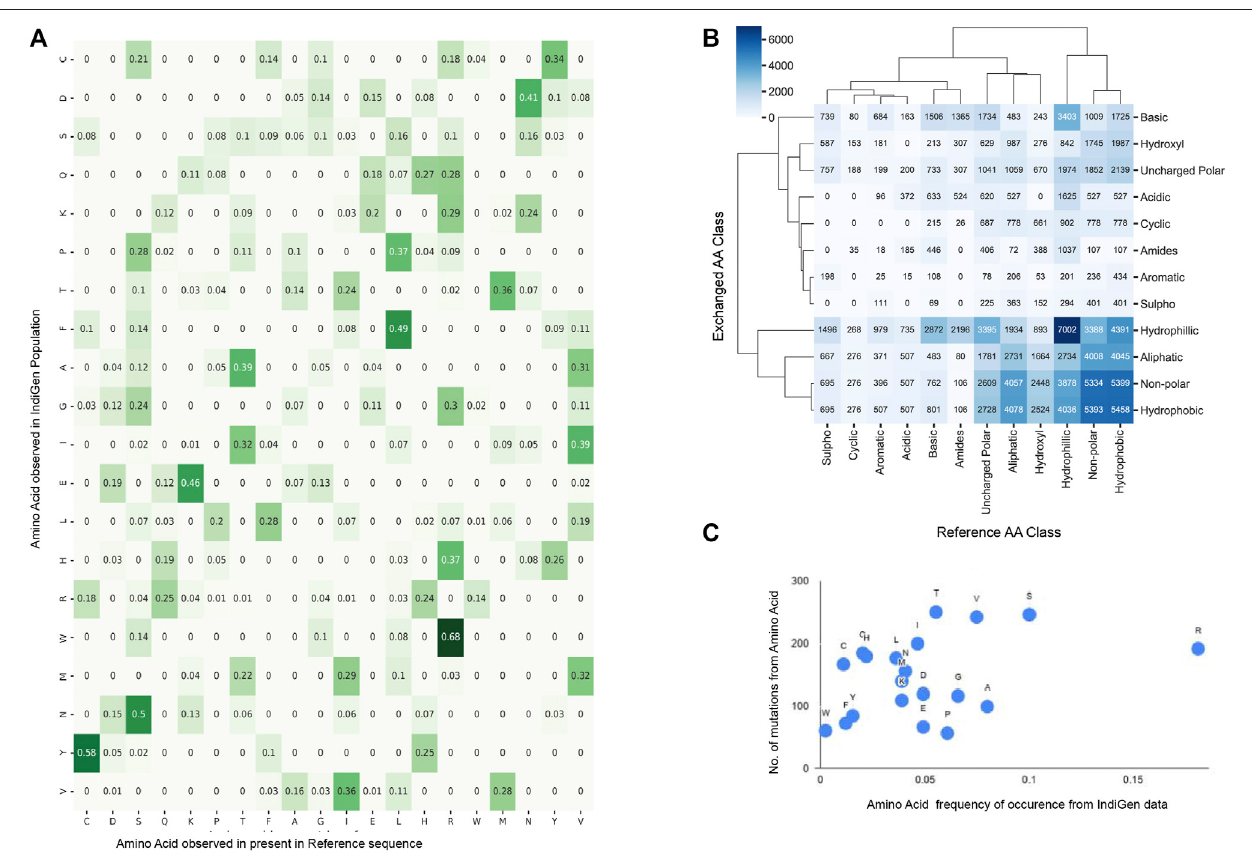
FIGURE 2 | Sequence Analysis using amino-acid exchanges reported for 545 druggable kinase Coding genes in IndiGen Data: (A) . Amino-acid exchange matrix forreferenceandalternateaminoacidsofSNVsinIndiGendata. (B) ClustermapshowingchemicalshiftobservedamongthereferenceandalternateaminoacidsatSNV sites reported in IndiGen data. (C) Scatter plot of mutability scores for each amino acid type in IndiGen data.